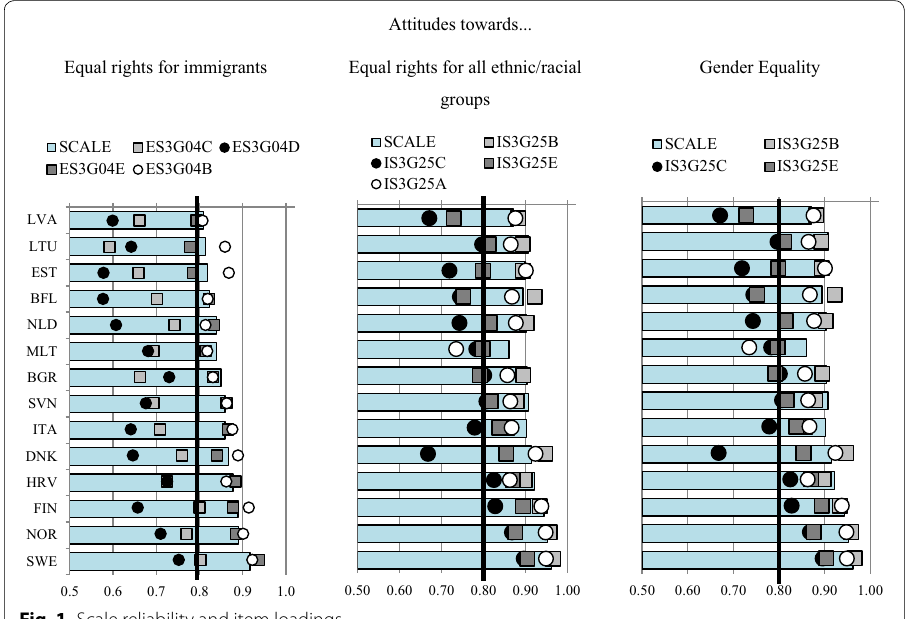
Fig. 1 Scale reliability and item